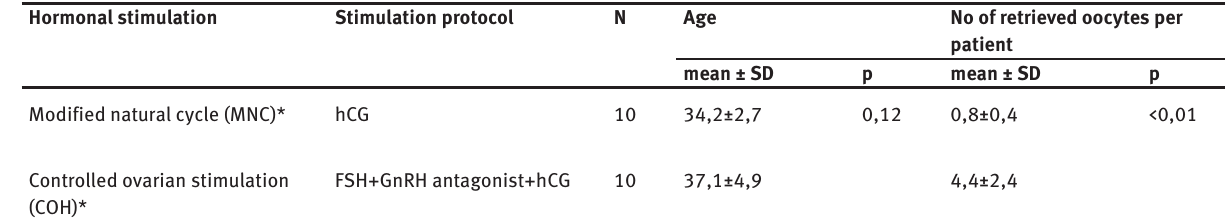
Table 1: Clinical characteristics of the patients included in the study. Hormonal